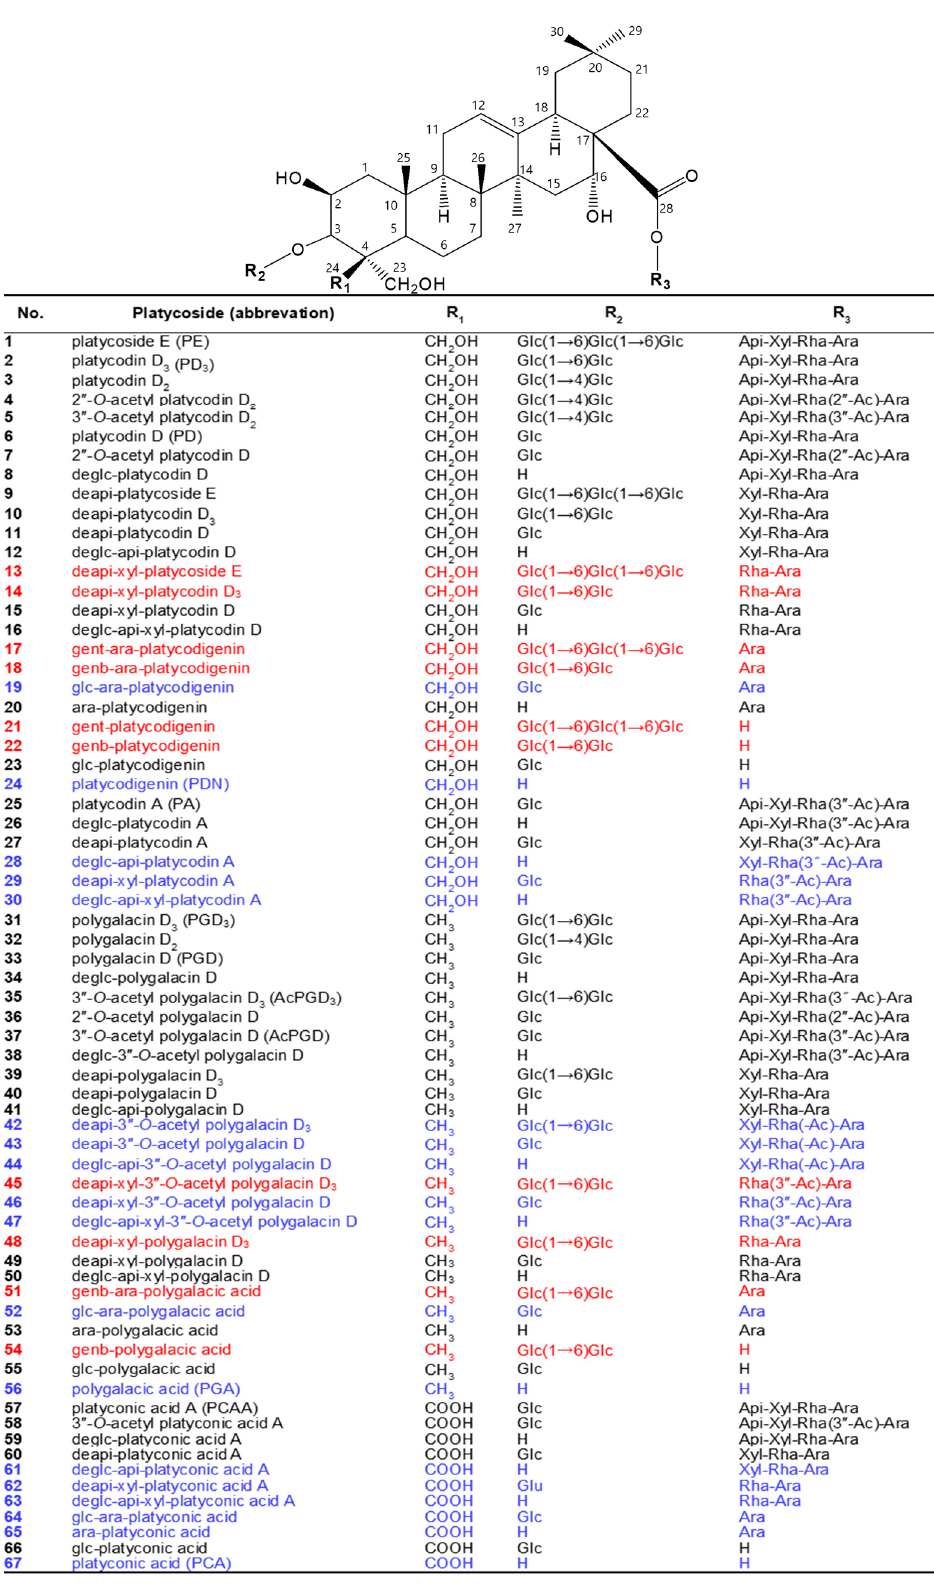
Figure 1. Chemical structures of major and minor platycosides and their glycoside moiety-hydrolyzed platycosides. The functional groups at C-4 (R 1 ) of PDN-type (platycosides 1 − 30), PGA-type (31 − 56), and PCA-type (57 − 67) platycosides are CH 2 OH, CH 3 , and COOH, respectively. Platycosides contain glycosides at C-3 and C-28. The glycosides at C-3 (R 2 ) are H, Glc, Glc-Glc, and Glc-Glc-Glc, whereas those at C-28 (R 3 ) are H, Ara, Rha-Ara or Rha(-Ac)-Ara, Xyl-Rha-Ara or